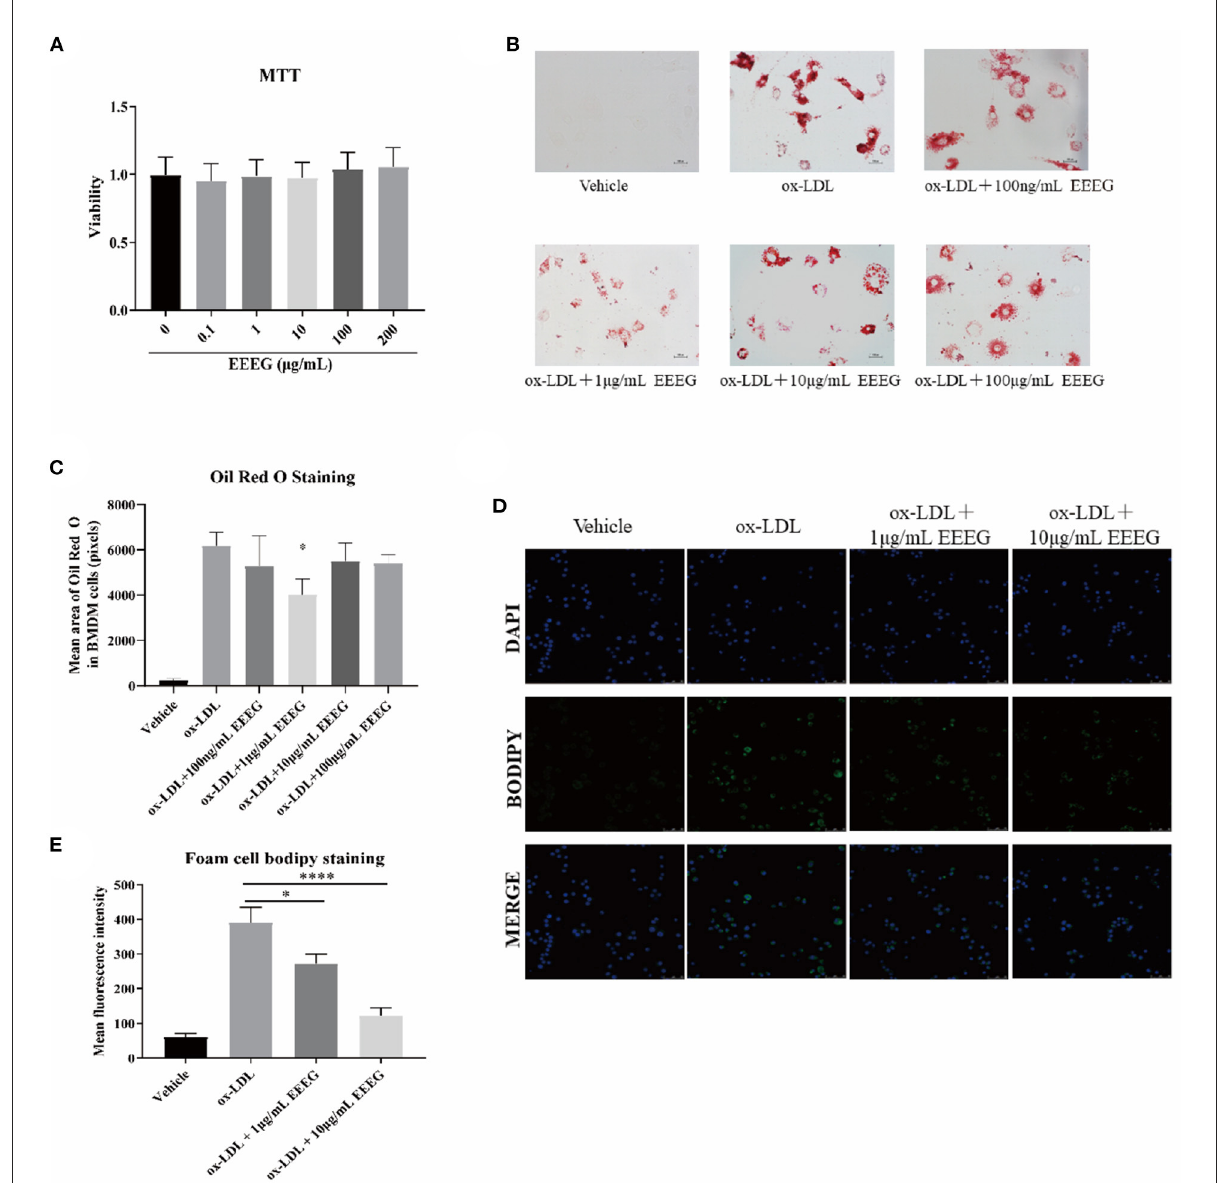
FIGURE1 EEEG treatment reduces macrophage foam cell formation. (A) Effect of EEEG treatment on BMDM viability. (B) Foam cell formation assayed by oil-red-O staining. Cells were incubated for 24h with ox-LDL in the presence or absence of EEEG, followed by Oil red O staining. (C) Quantification of ox-LDL uptake by macrophages. (D) BODIPY staining of RAW 264.7 cells. Cells were incubated for 24h with ox-LDL in the presence or absence of EEEG, followed by BODIPY staining. (E) Quantification of BODIPY fluorescence staining. Data are expressed as mean ± s.e.m., Statistical analysis was based on Graphpad Prism 9.0.2 software and a value of P < 0.05 was considered statistically significant. One-way ANOVA with Student Neuman-Keuls post-hoc test was performed to compare the data between multiple groups, * p < 0.05, **** p < 0.0001 vs.